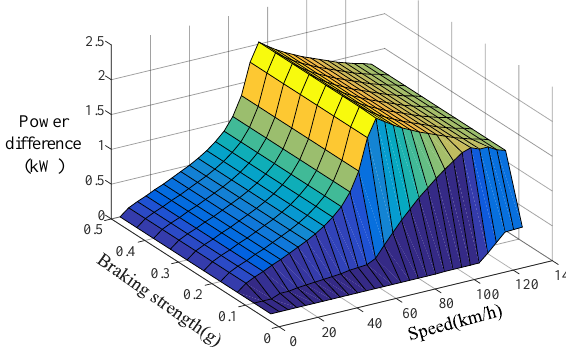
Figure 11. Power differences before and after compensation.